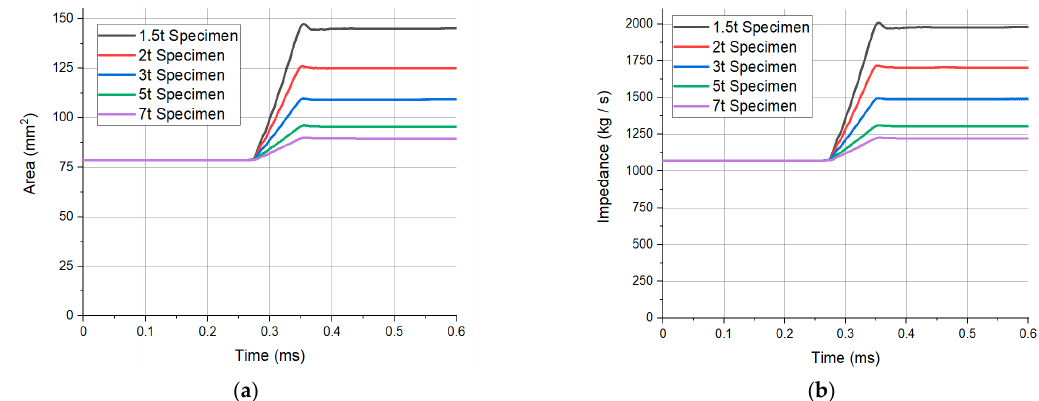
Figure 8. Real-time, specimen; ( a ) area; and ( b ) impedance graph obtained from the analysis of each thickness.